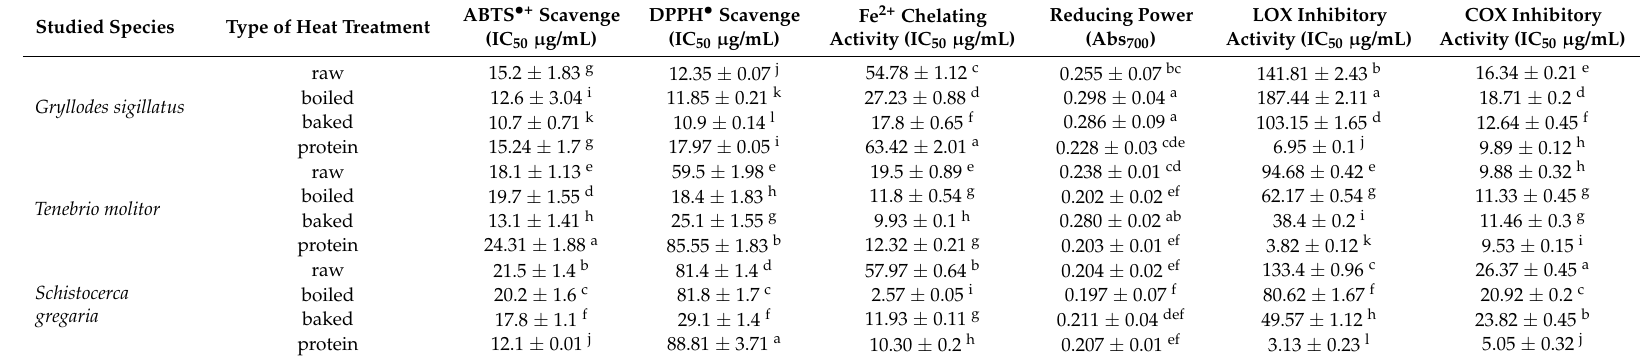
Table 2. The antioxidant and anti-inflammatory activities of samples after the in vitro absorption